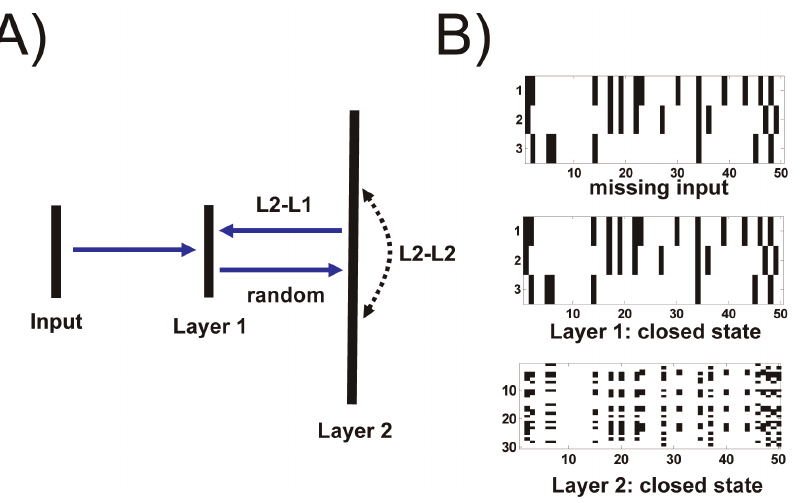
Figure 6. Hidden layer learns a generative model of a long sequence of spike trains. ( A ) The three neurons in layer 1 (Layer 1) are clamped to input spike trains (in this example, a random pattern with spike frequency of 0.2). During the open state, these neurons project (through synaptic weights sampled from a random uniform distribution between -1 and 1) to a much larger hidden layer (Layer 2) which in this example contains thirty neurons. Synaptic state matching in the intra-layer 2 synaptic connections (L2-L2) gives rise to an accurate predictive model within this hidden layer. Synaptic state matching of synapse projections from layer 2 to layer 1 (L2-L1) generates an accurate predictive model of the missing input at layer 1. Layer 1 neurons do not have any internal recurrent connections. ( B ) top: missing input into layer 1 during the closed state; middle: predicted pattern of missing input created by the projection of hidden layer axons to layer 1 during the closed state. The pattern is a perfect match to the missing input; bottom: the coincident activity of the 30 neurons in the hidden layer during the closed state. SSM parameter choices for both L2-L2 and L2-L1 connections were as follows: potentiation strength ( a ): 5 6 10 2 4 , spike-rate memory (m s ): 200, potentiation memory (m p ): 50, state switching period: (Gaussian, t m =30, t s =10), neuron firing threshold (V t ): 0.5, sigmoid sharpness (S): 10, latency range (L): 20.